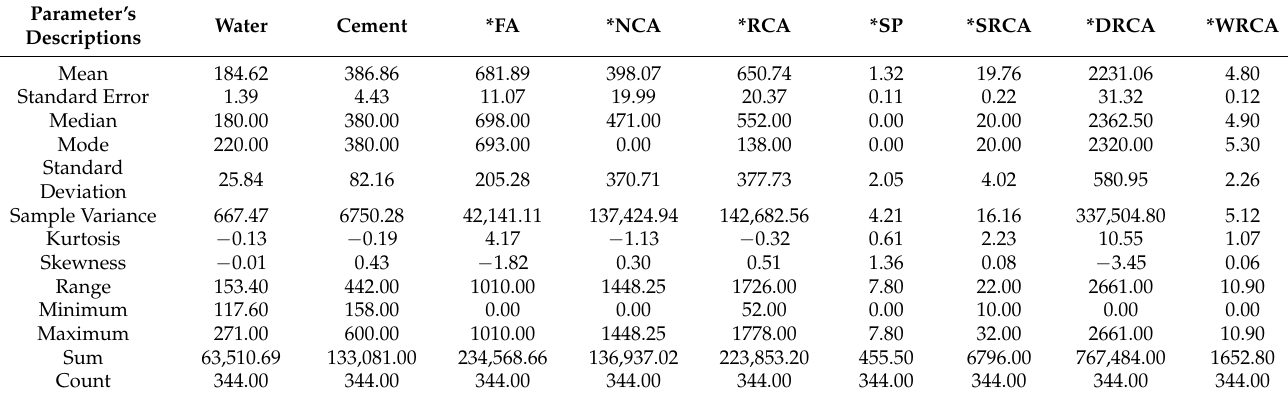
Table 1. Descriptive analysis of the input